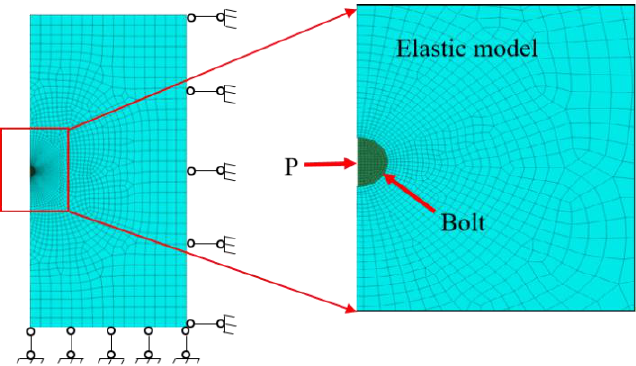
Figure 7. FLAC3D model of bolted rock joints at compression-shear side. Table 1. Mechanical parameters of bolt